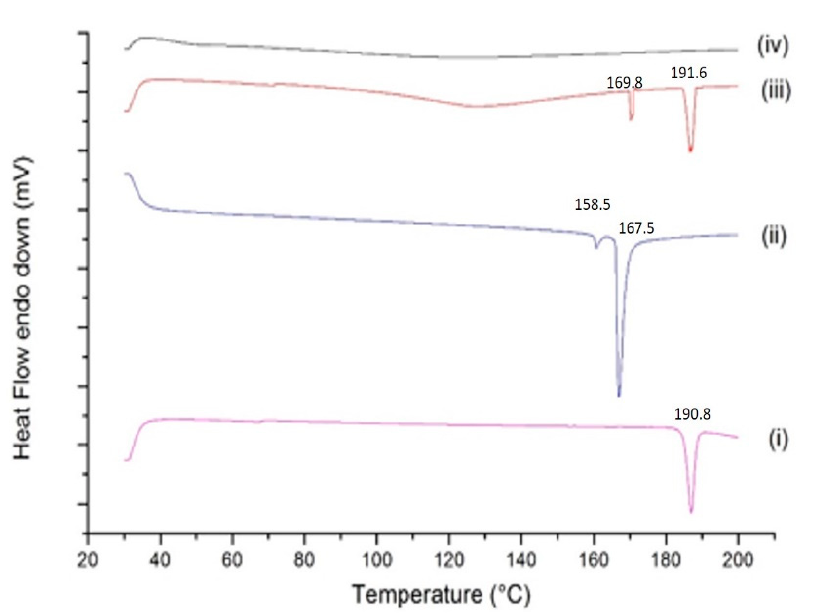
Figure 5. Thermograms of bedaquiline (i), SBE- β -CD (ii), the physical mixture of bedaquiline and SBE- β -CD (iii), and the inclusion complex BDQ-CD